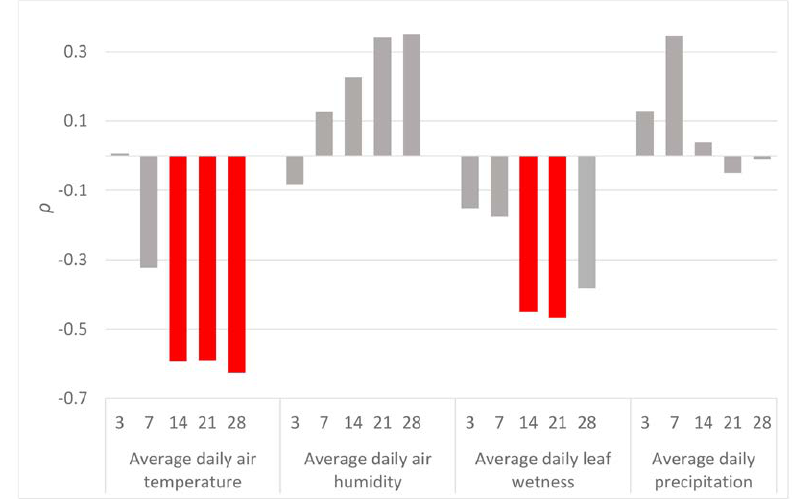
Figure 3. Spearman’s correlation coefficients ( ρ ) between the amount of the detected inoculum in the air samples (CN) and meteorological variables (air temperature, air humidity, leaf wetness and precipitation). For each meteorological variable, daily values were averaged across the 3, 7, 14, 21 and 28 days before the end of each spore sampling. Significant correlation coefficients are displayed in red.